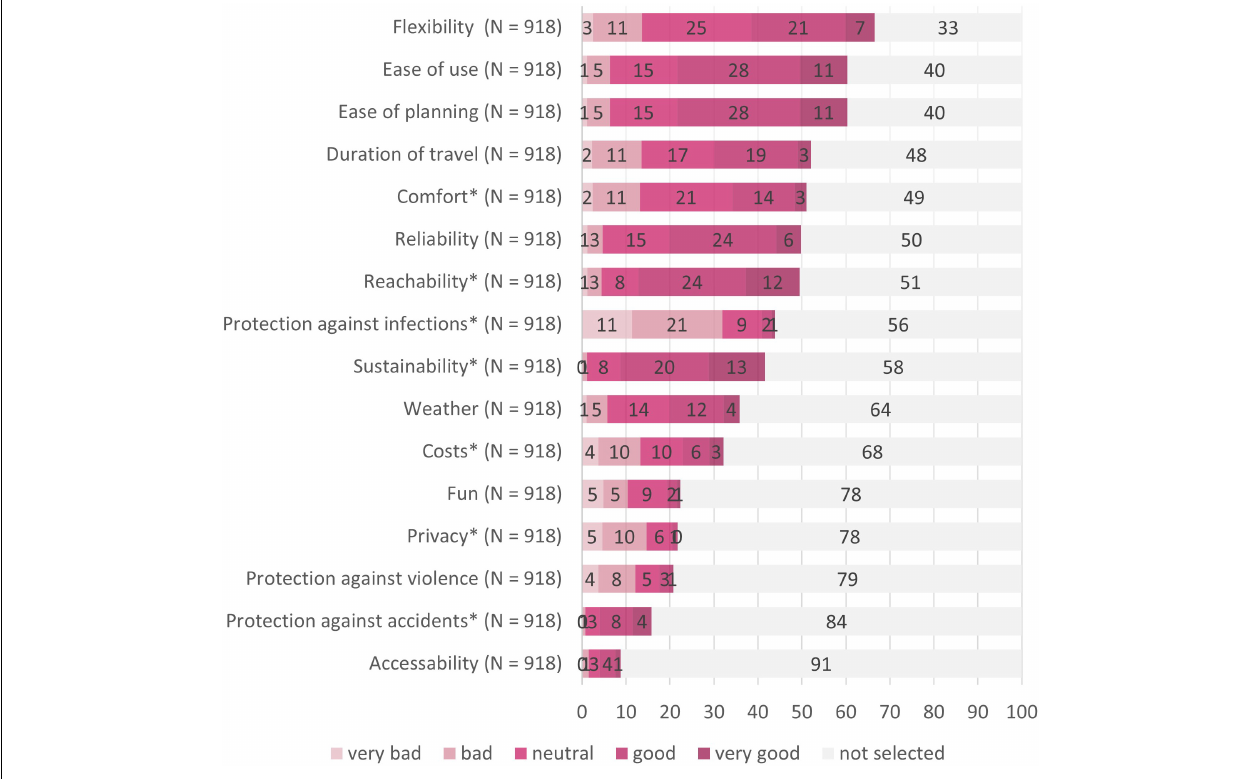
p < 0.001, d = 0.38, 95% CI [0.24; 0.51] and reducers, χ 2